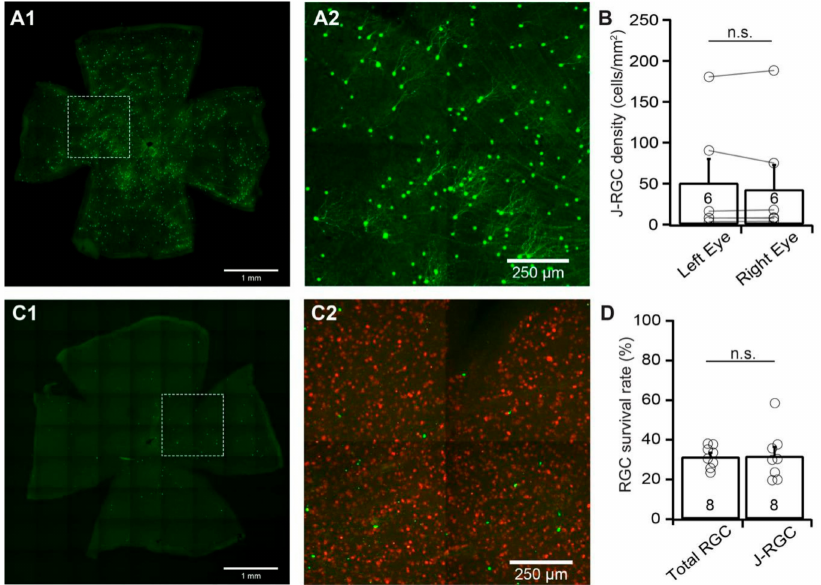
Figure 5. The vulnerability of J-RGCs to ONC. The densities of YFP-expressing J-RGCs of left and right eyes of JamB:YFP mice without ONC were compared to determine the YFP expression level of the left and right eyes without injury. The density of the YFP-expressing J-RGCs of left eyes with ONC was quantified, normalized to that of uncrushed right eyes, and compared with the density of anti-RBPMS-labeled RGCs of the same eyes. (A) A representative image of a flat-mount JamB:YFP mouse retina without ONC ( A1 ) to show the distribution of YFP-expressing J-RGCs in the retina, and a magnified view of the dash-line box of A1 to show the dendritic morphology of YFP-expressing J-RGCs ( A2 ). ( B ) Comparison of the average densities of YFP-expressing J-RGCs from the retinas of the uncrushed right and left eyes of the same group of JamB:YFP mice. The di ff erence between the right and left eyes is not statistically significant (number of mice n = 6, paired t -test, p = 0.7871). n.s.: not significant. The circles are individual eyes. ( C ) A representative image from the retina of a JamB:YFP mouse with the labeling of YFP-expressing J-RGCs (green) 7 days after ONC ( C1 ) and a magnified view of the boxed area in C1 with labeling of both YFP-expressing J-RGCs (green) and RGCs labeled by anti-RPBMS antibody (red, C2 ). ( D ) Comparison of the average survival rates of anti-RBPMS-labeled RGCs and YFP-expressing J-RGCs from the same eyes seven days after ONC. The densities of anti-RBPMS-labeled RGCs and YFP-expressing J-RGCs of the eyes with ONC are normalized to their uncrushed control eyes for each mouse. The survival rates of YFP-expressing J-RGCs are not significantly di ff erent from that of anti-RBPMS-labeled RGCs from the same eyes (number of mice n = 8, paired t -test, p = 0.9421). n.s.: not significant. The number in each column of panels B and D is n, and the circles are individual